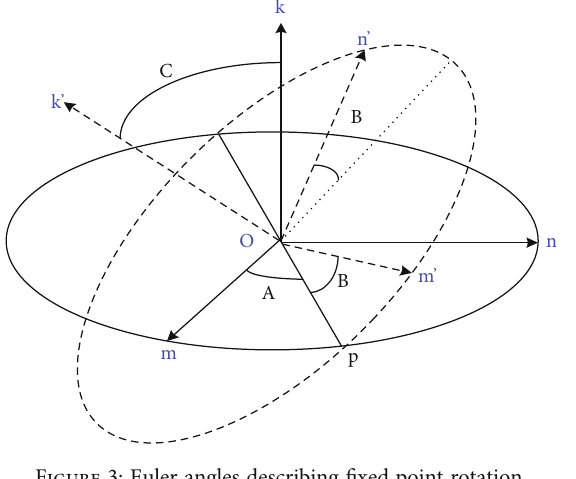
Figure 3: Euler angles describing fi xed point